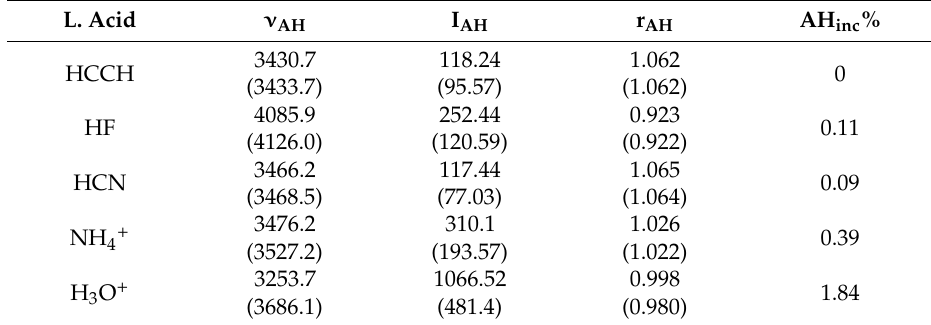
Table 3. The spectroscopic characteristics of the proton-donating bond in hydrogen bonded systems; the A-H bond stretching frequency (cm − 1 )— ν AH , with the corresponding stretching mode intensity (km mol − 1 )—I AH , and the A-H bond length r AH (in Å); these values for the AH bond not involved in H-bond interaction are given in parentheses, AH inc %—the percentage increase of the AH bond length that results from complexation (Equation